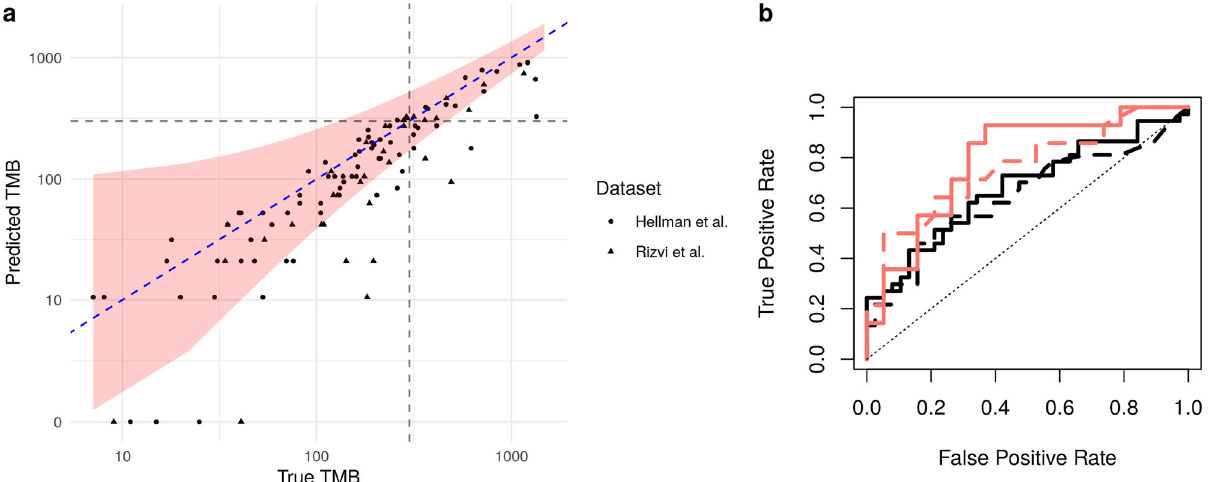
Fig. 7 External test set regression and classi fi cation performance. a Performance of our model trained on the Campbell et al. 20 dataset used to predict TMB based on the panel of size 0.6 Mb selected by our method on the external test datasets of Hellman et al. 21 and Rizvi et al. 22 . b ROC curves for classifying the response to immunotherapy in the Hellman et al. 21 (black) and Rizvi et al. 22 (red) datasets using the true TMB values (solid) and estimated TMB values (dashed) based on the panel of size 0.6 Mb selected by our